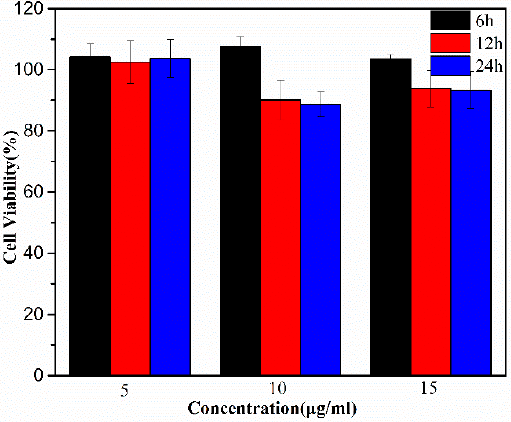
Figure 12. Cell viability of the obtained polymer at different concentrations.